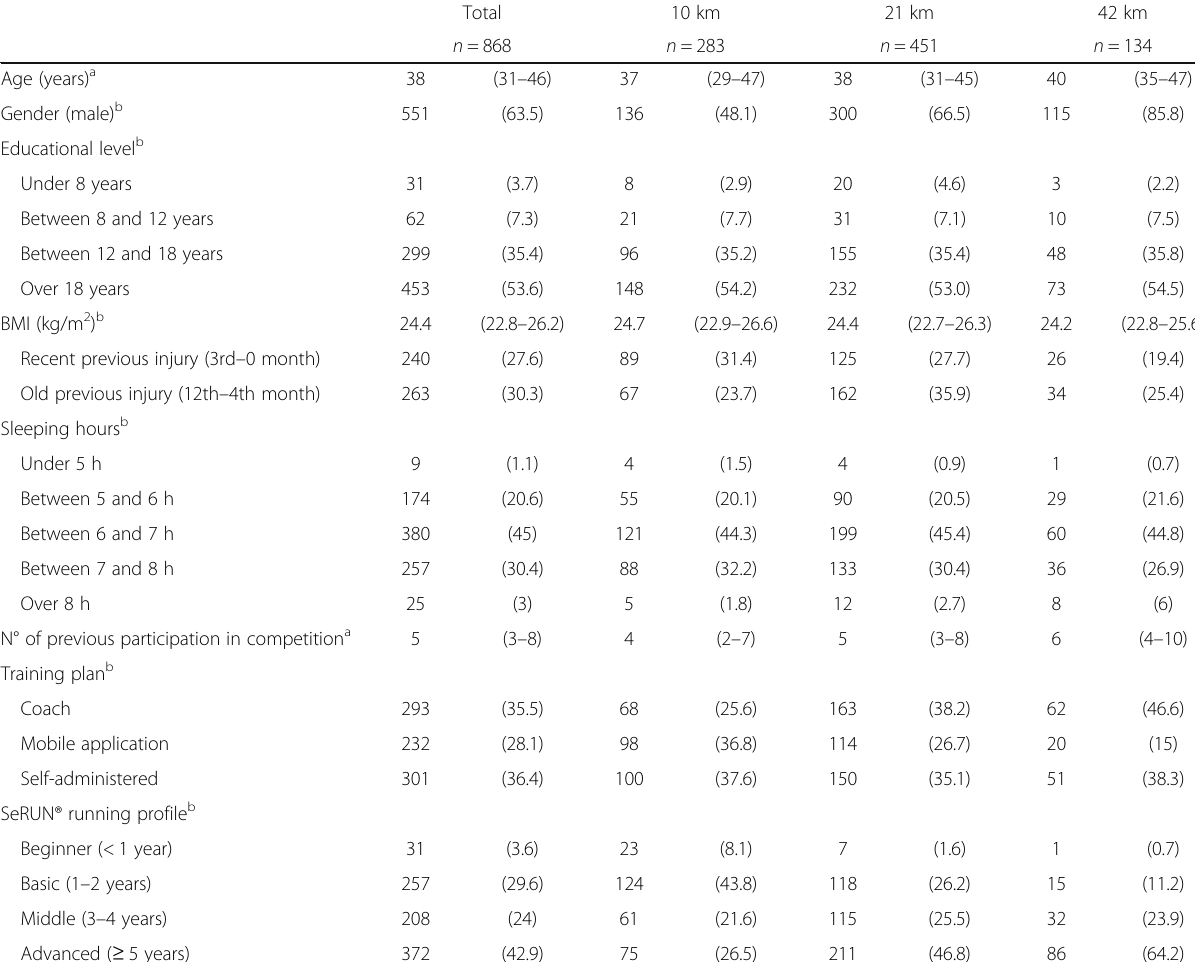
Table 1 Description of socio-demographic, health characteristics and running practice based on the registered distance